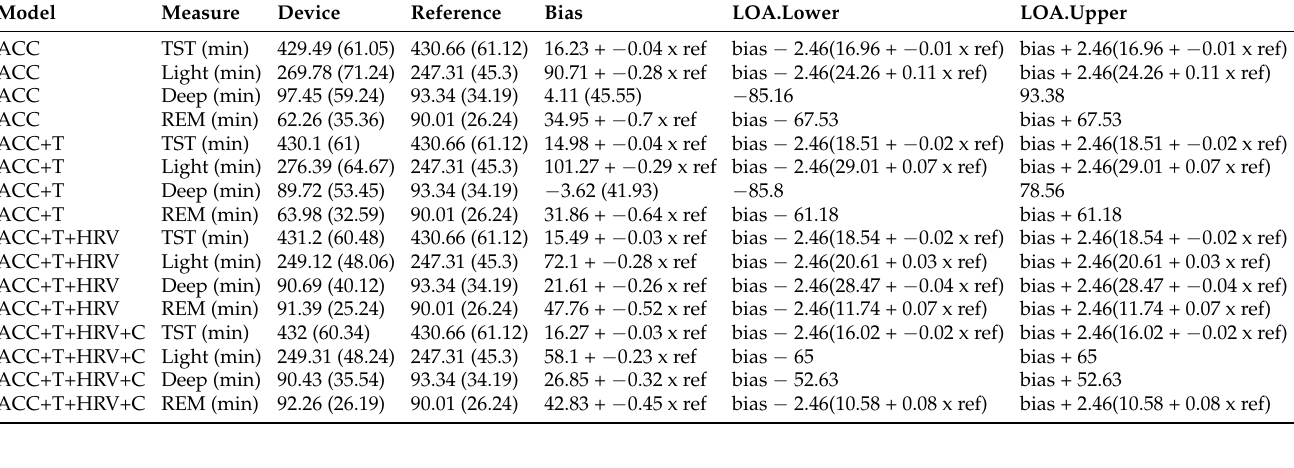
Table 3. Bias and limits of agreement for TST, time in light, deep, and REM sleep for 4-stage classification and the four models analyzed in this paper.